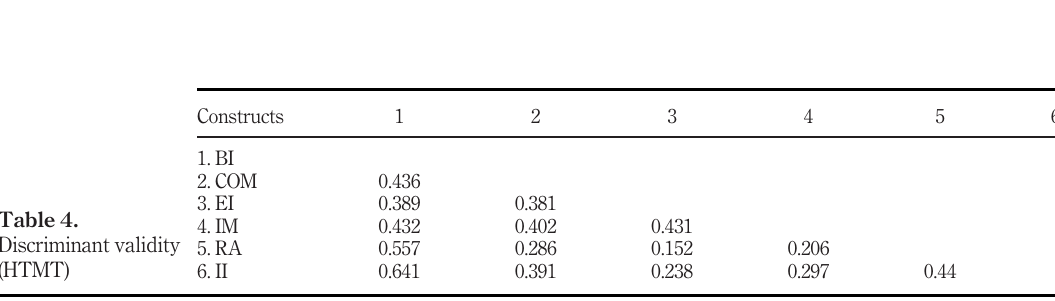
Table 4. Discriminant validity